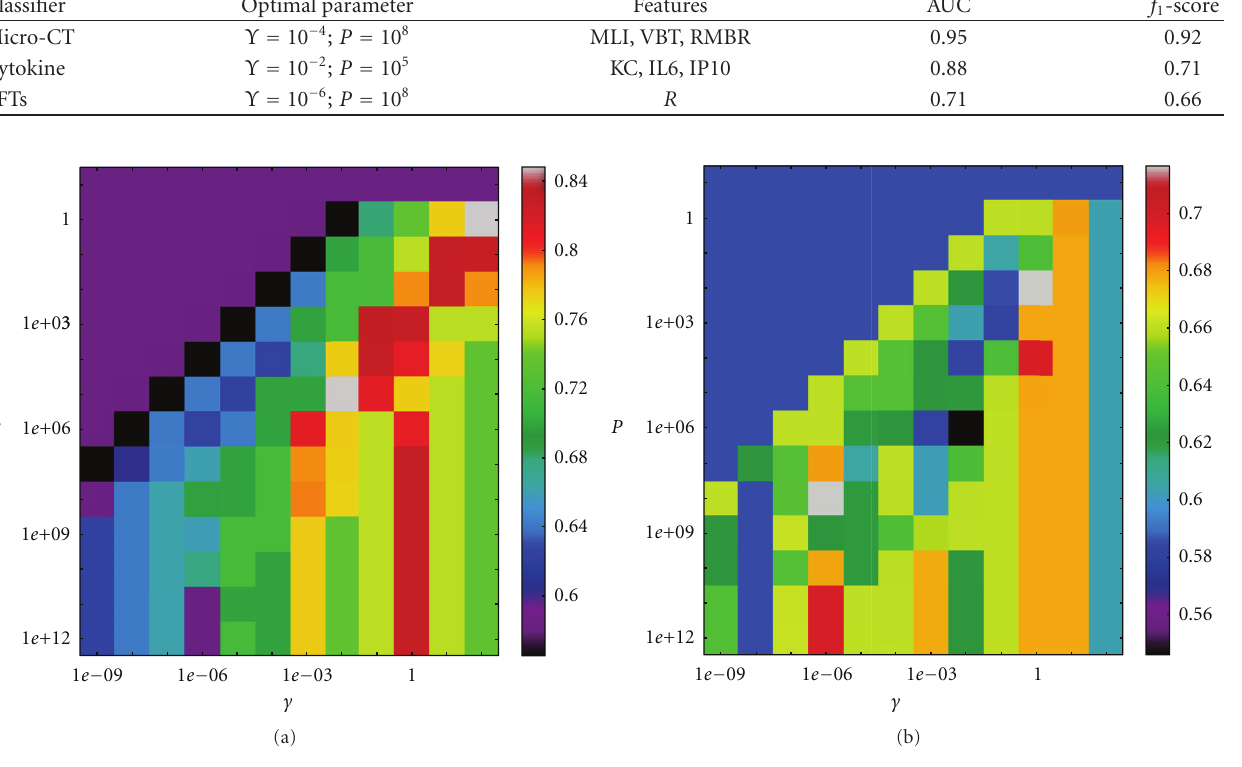
Figure 9: Cross-validation accuracy plot for the selection of the optimal work parameters for: (a) cytokine expression classifier ( Υ = 10 − 2 and P = 10 5 ); (c) pulmonary function tests classifier ( Υ = 10 − 6 and P = 10 8 ).